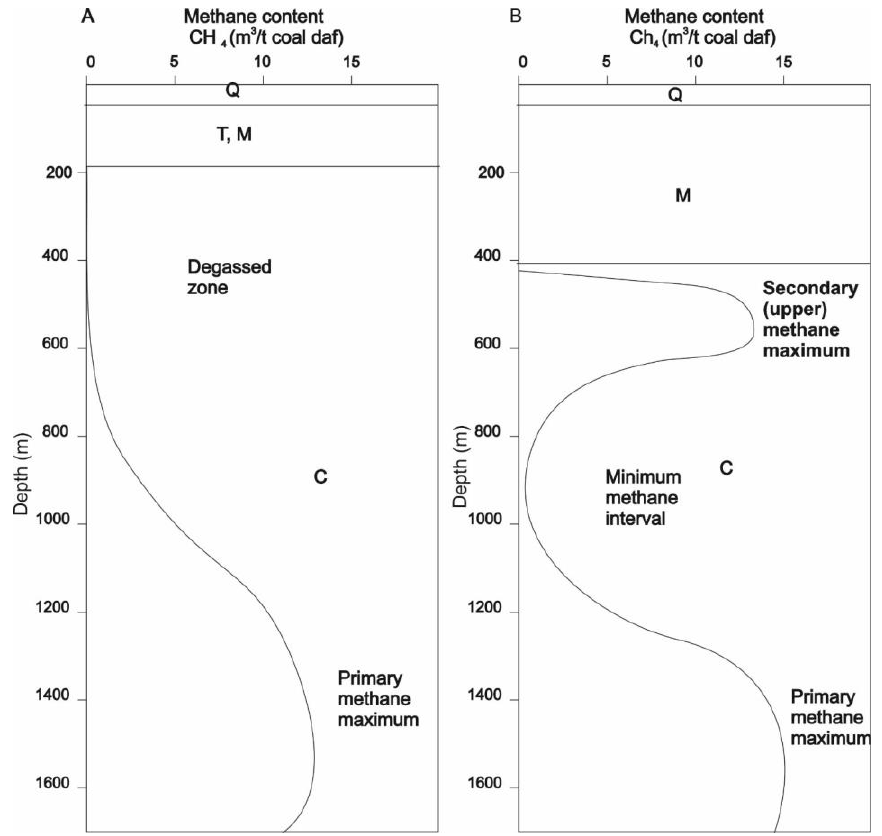
Fig. 2. Methane distribution in the northern (A) and southern (B) parts of the USCB (modified after Kędzior, 2012, 2015a; Kotas. 1994), Q – Quaternary, T – Triassic, M – Miocene, C – Carboniferous